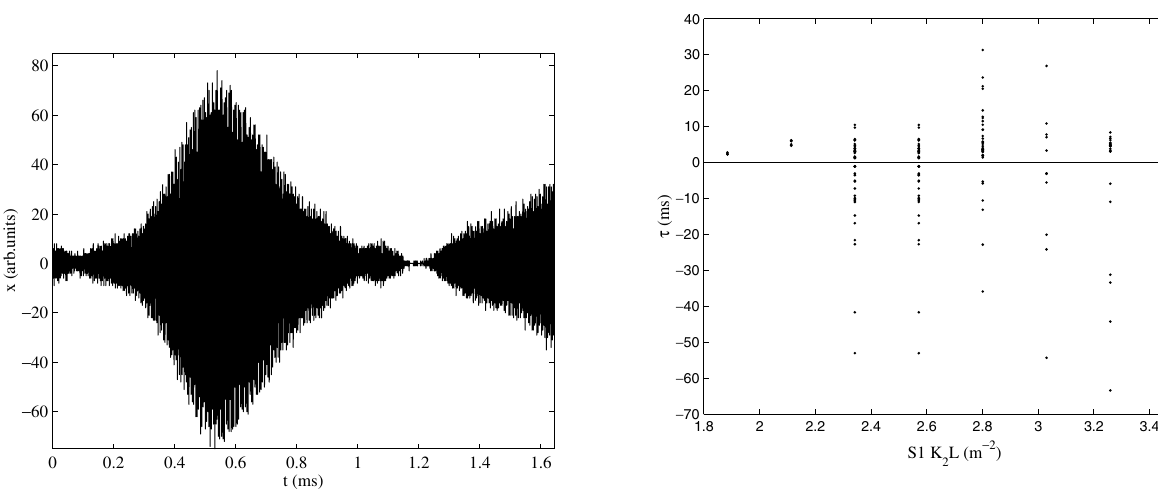
FIG. 11. Rise and damping times of the unstable modes as a function of the harmonic sextupole